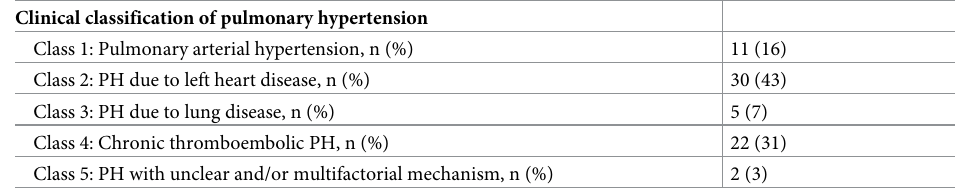
Table 2. Clinical classification pf pulmonary hypertension in this cohort. Clinical classification of pulmonary